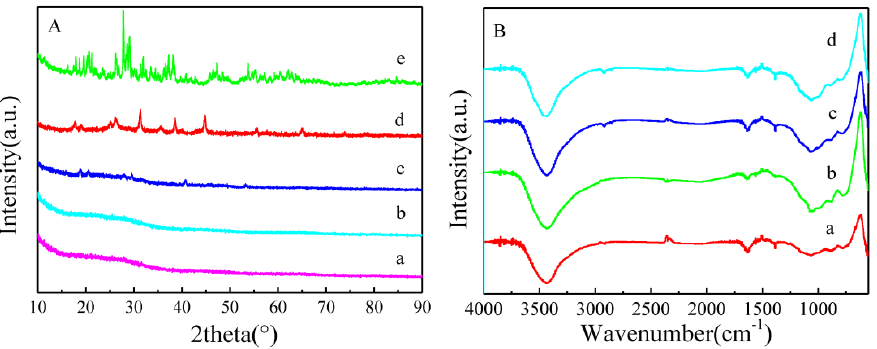
Figure 12. XRD ( A ) and FT-IR spectra ( B ) of (a) SF-HPC, (b) 1% HPW/SF-HPC, (c) 5% HPW/SF-HPC, (d) 10% HPW/SF-HPC, and (e) HPW. Reprinted from Ref. [15]. Copyright 2021 by the